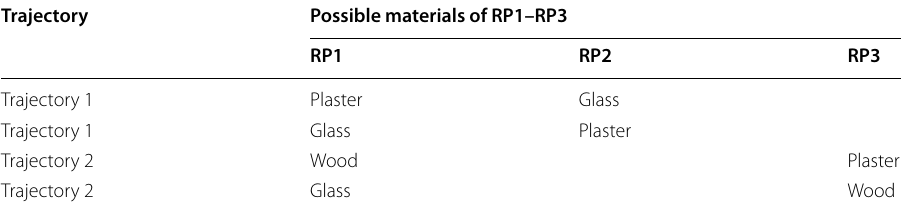
Table 5 Possible materials of RP1-RP3 derived from two independent trajectories